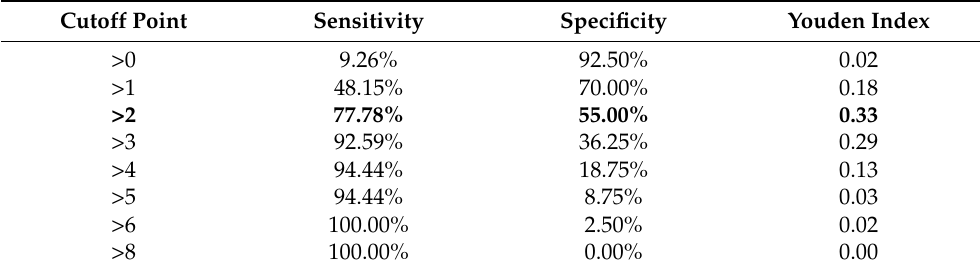
Table 3. Sensitivity, specificity, and Youden Index of the SUNFRAIL tool. Cutoff Point